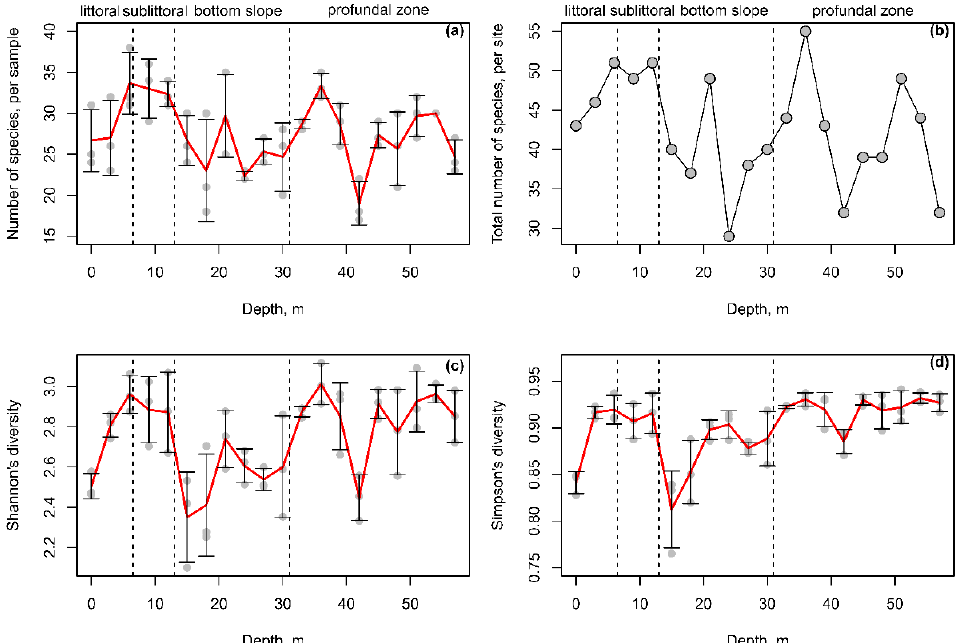
Figure 8. Mean number of species per sample ( a ) the total number of species per site ( b ), Shannon’s ( c ), and Simpson’s ( d ) diversity indices of testate amoeba assemblages along the depth gradient in Lake Valdayskoe. Bars are standard deviations; vertical dashed lines mark the borders between the depth zones.